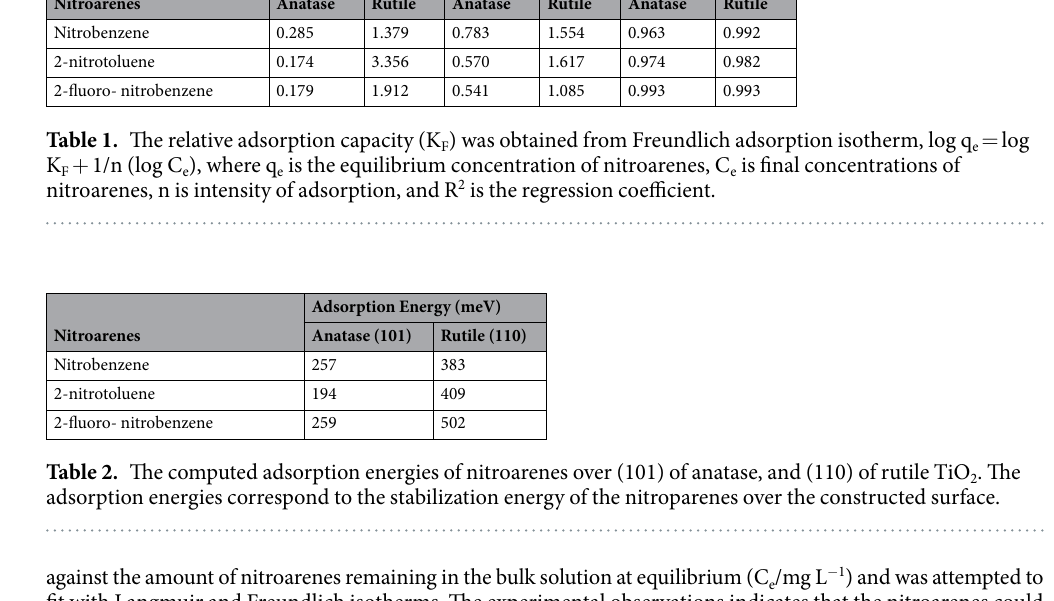
against the amount of nitroarenes remaining in the bulk solution at equilibrium (C e /mg L − 1 ) and was attempted to fit with Langmuir and Freundlich isotherms. The experimental observations indicates that the nitroarenes could get adsorbed on to anatase and rutile TiO 2 according to the Freundlich isotherm model (Fig. 7) and the value of regression coefficient for the adsorption model was closed to unity (Table 1). To our surprise, all the nitroarenes were better adsorbed over rutile than anatase TiO 2 and the relative adsorption capacity was higher almost by an order of magnitude (vide Freundlich exponent, K F in Table 1). Independently, we have also performed the nitroarenes adsorption from First-principles DFT calculations. As evident from XRD, (101) and (110) are the most exposed facets of anatase and rutile, respectively, nitroarenes were adsorbed over these constructed surfaces (Fig. 8) and the computed adsorption energies are given in Table 2. For all the nitroarenes the adsorption energy minima are almost twice over rutile (110) compared to anatase (101). This is corroborating our experimental adsorption results. Therefore, it can be concluded that though nitroarenes adsorption over rutile is higher but it